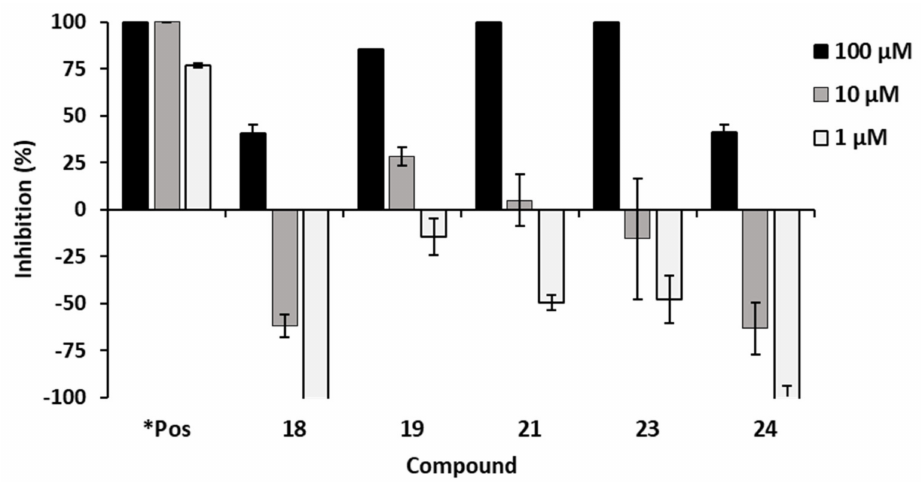
Figure 7. Antibacterial assay with compounds 18 , 19 , 21 , 23 and 24 against Gram-negative Aliivibrio fischeri . Chloramphenicol was used as the positive control labelled as *Pos . Negative values indicate an increase of bacterial growth in comparison to the negative control (0%